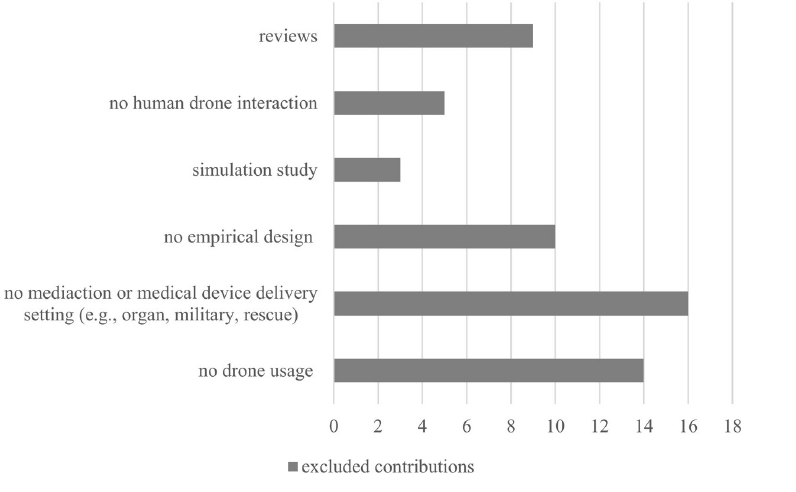
Fig 2. Systematic search flow